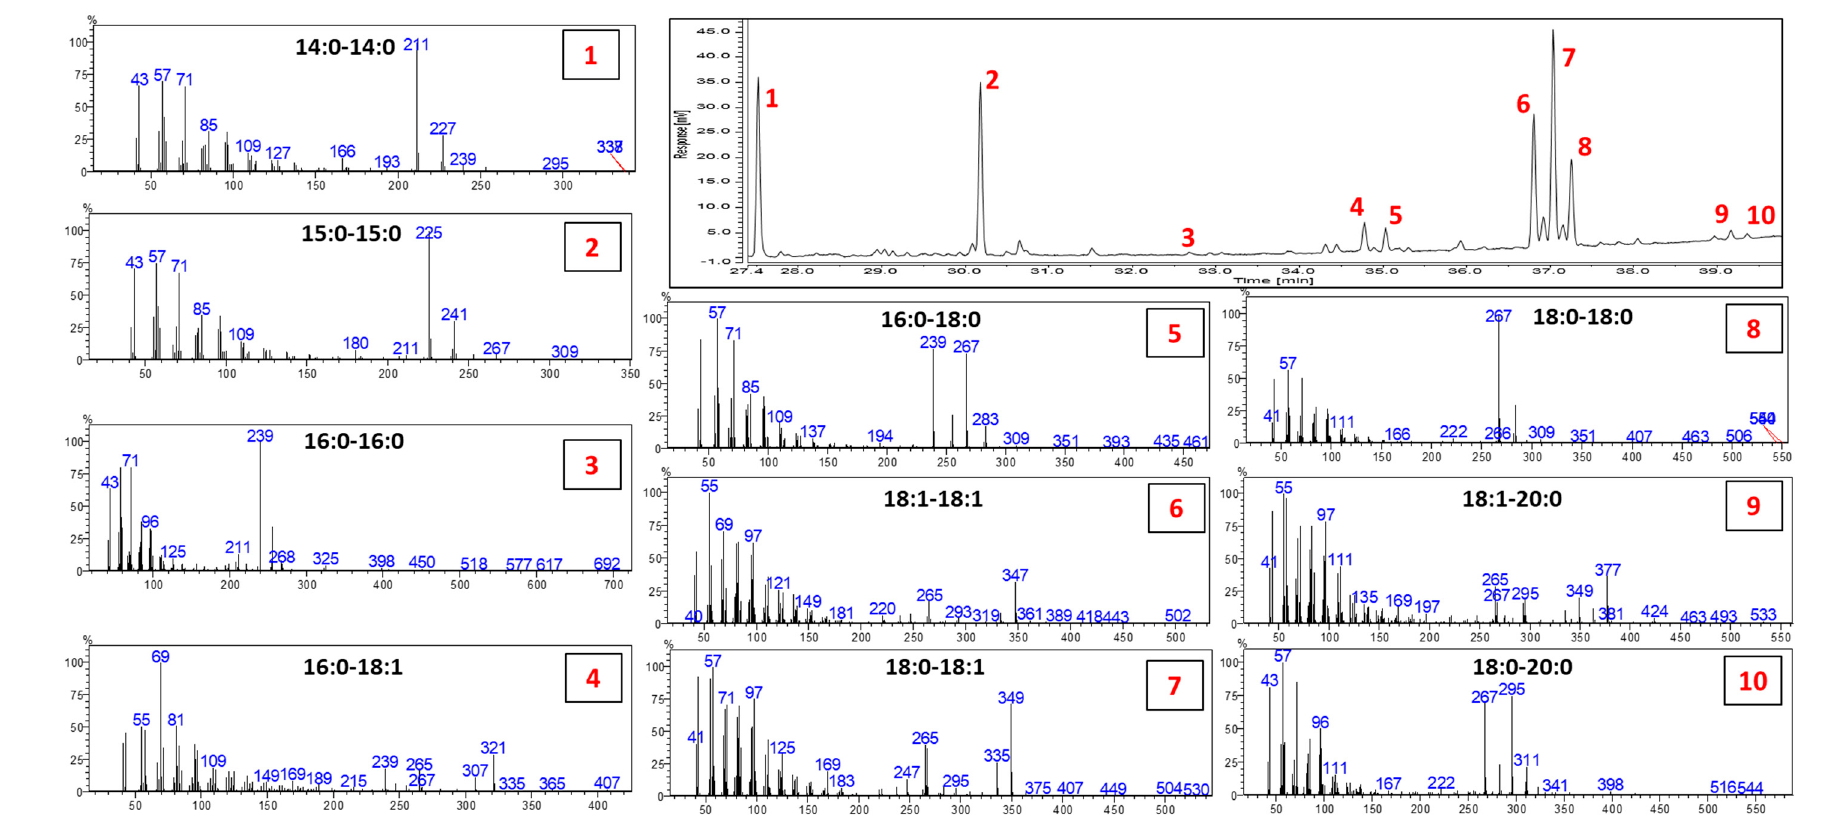
Figure 4. GC trace of the chemically interesterified rapeseed oil (60/40 raw and hydrogenated, respectively). The MS spectra of each of the identified peak are reported labeled with the same number of the corresponding peak and reporting the identification of the DAK.